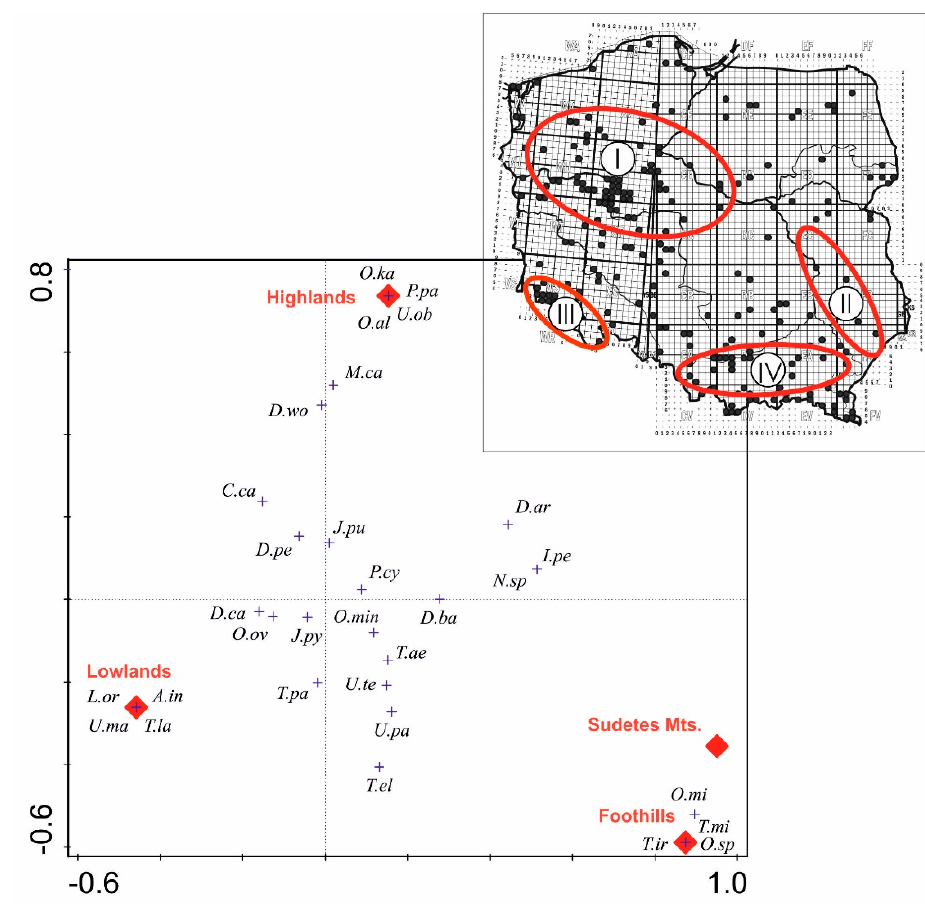
Figure A2. Canonical Correspondence Analysis (CCA) scatterplot showing the relationships between examined Uropodina mite communities from beech from different regions of Poland from 3 samples from the Sudetes (III), 17 from Carpathians foothills (IV), 27 from highlands (II) and 62 from lowlands (I) on the first two axes. First and second axis explained 3.67% of variation (pseudo-F = 1.6, p = 0.072). Abbreviations of species are included in Section 2.